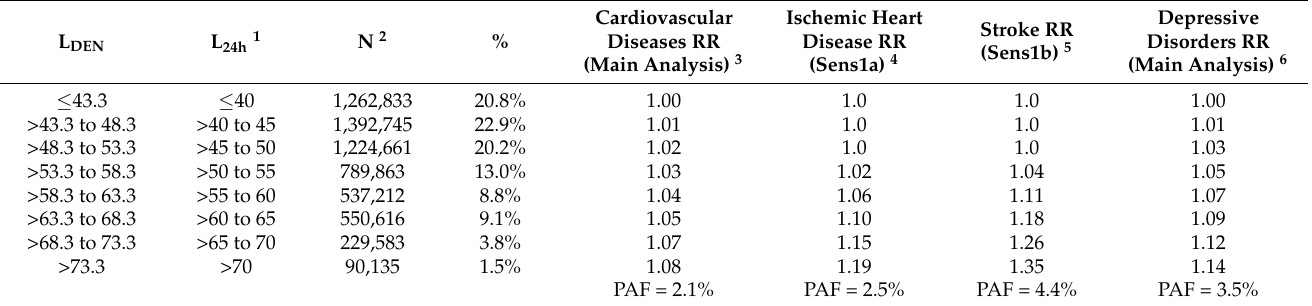
DEN values of 53 dB(A) using the dose-response relationship for ischemic heart disease: 1.08 per 10 dB(A) [3,30]. The analysis used finer 0.1-dB(A) categories for calculating PAF; 5 risks shown for the middle of the categories starting from L DEN values of 53 dB(A) using the dose-response relationship for stroke: 1.14 per 10 dB(A) [3,30]. The analysis used finer 0.1-dB(A) categories for calculating PAF; 6 risks shown for the middle of the categories starting from L 24h values of 40 dB(A) using the dose-response relationship for depressive disorders: